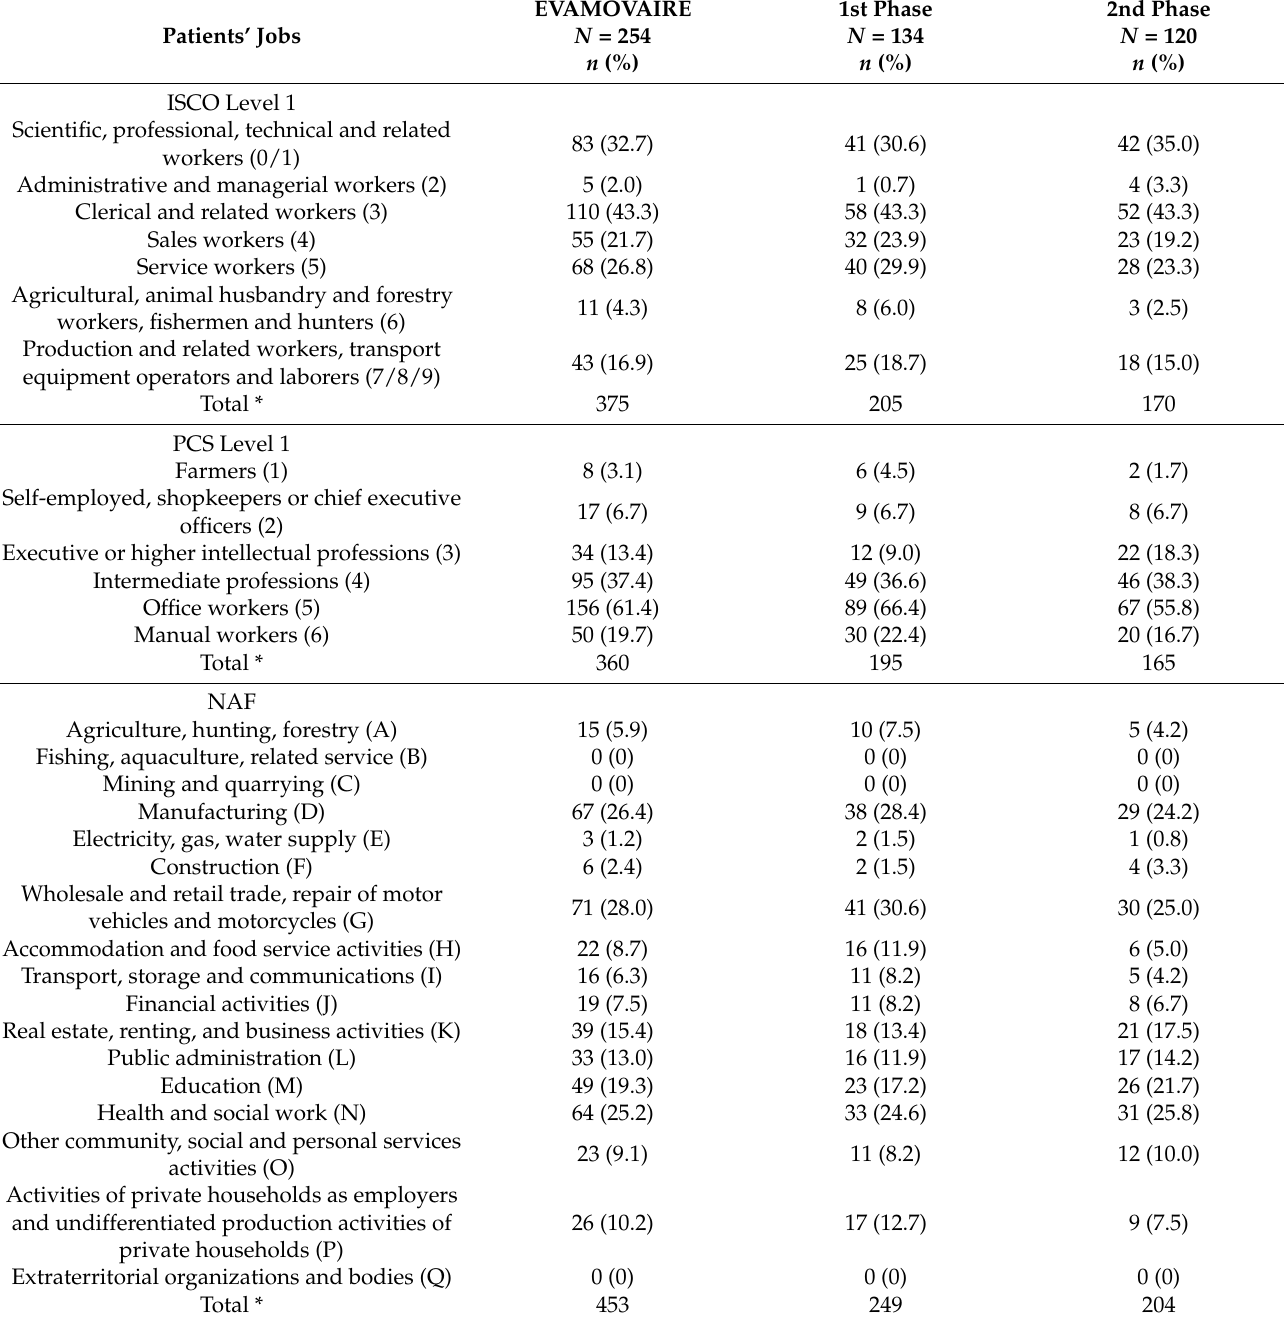
Table 2. Distribution of patients’ jobs by ISCO, PCS, and